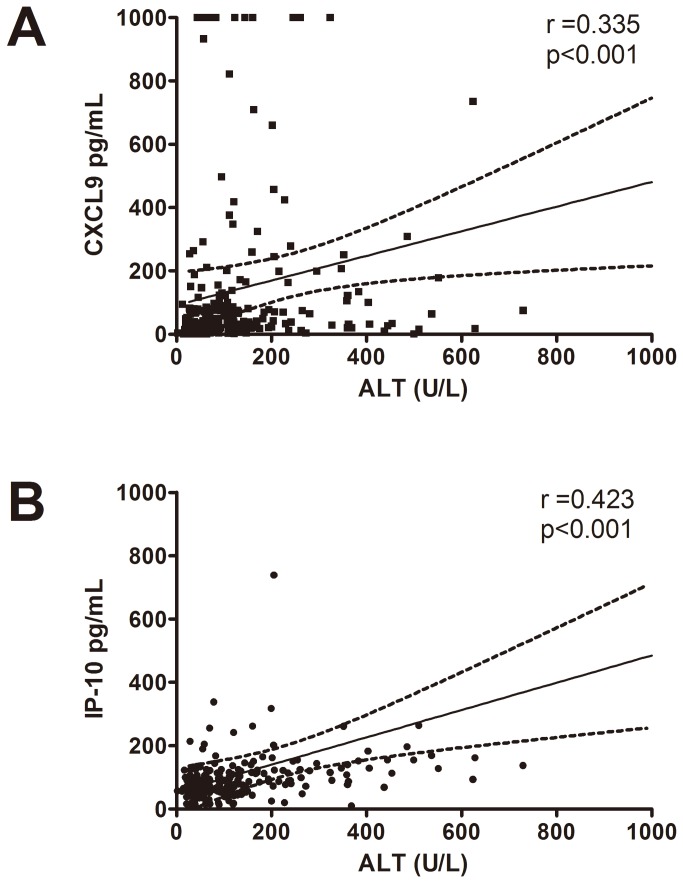
Correlations between serum ALT and chemokine levels.(A) A positive correlation between CXCL9 and ALT; (B). A positive correlation between IP-10 and ALT. Concentrations of serum ALT, CXCL9 and IP-10 levels were collected at each time point during PEG-IFN treatment (overall n=232).